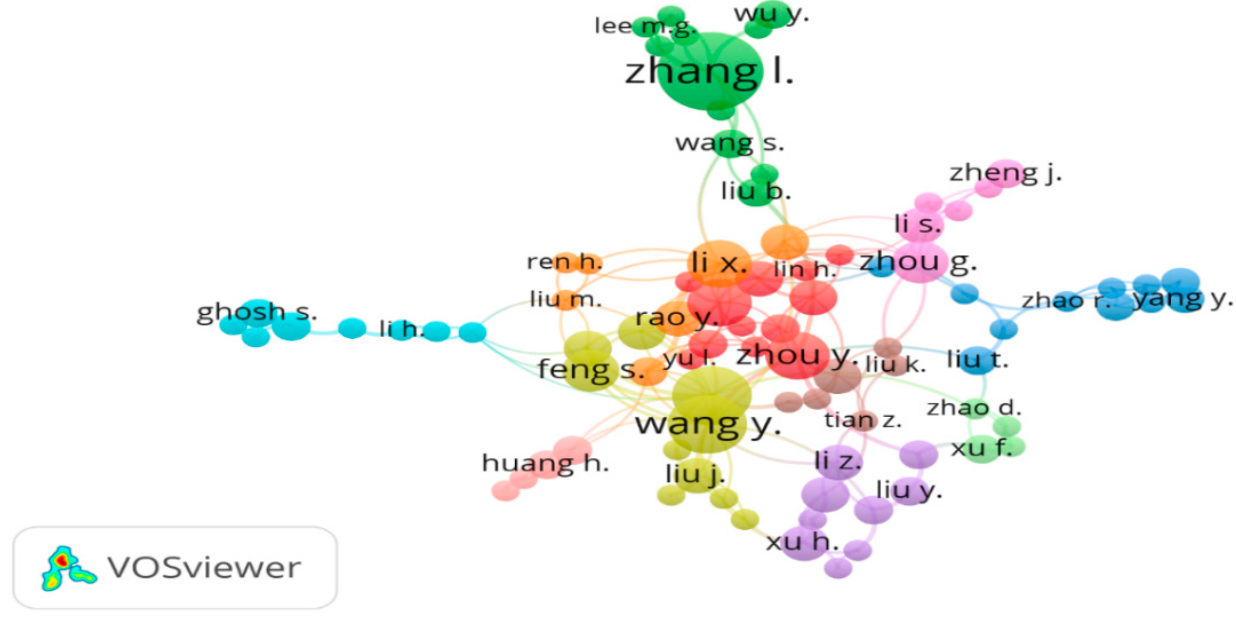
Figure 16. Co-authorship network diagram. Table 15. Top 10 authors with their links and number of documents published. Authors